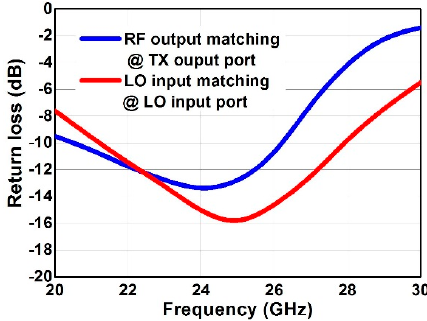
Figure 11. Measured return loss versus operating frequencies.